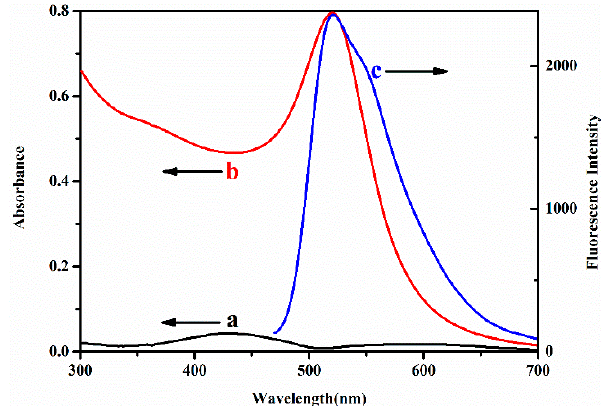
Figure 1. The absorption spectra of the CPNs (a) and AuNPs (b) and fluorescence emission spectrum of CPNs (c).